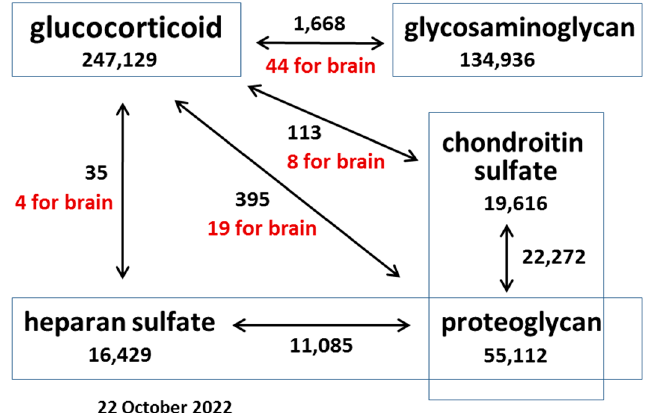
Figure 1. Scheme representing the relative number of publications related to the effects of GCs on O-glycosylated molecules different cells and tissues as of 22 October 2022. Keywords are in rectangles, and the number below a keyword represents the number of publications retrieved from the PubMed database. Arrows indicate a combination of keywords, and the number next to an arrow indicates the number of publications for each combination of keywords (of which a certain number includes the additional keyword “brain” (highlighted in red)).